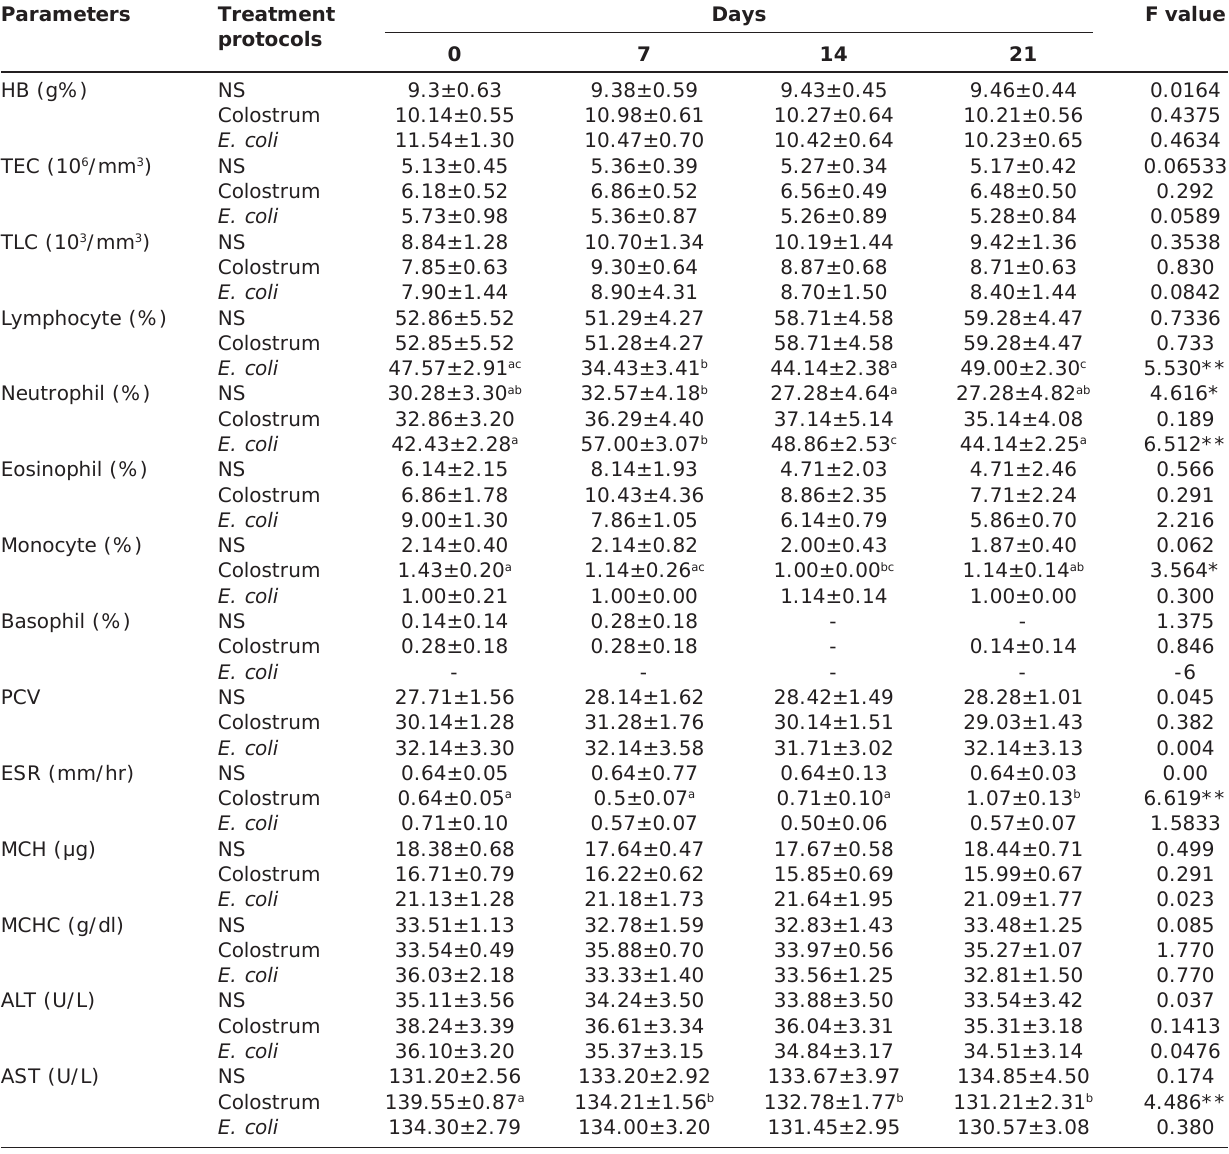
Table-1: Mean and test of significance (F-test) of different hematobiochemical parameters in various experimental groups within days of sampling.